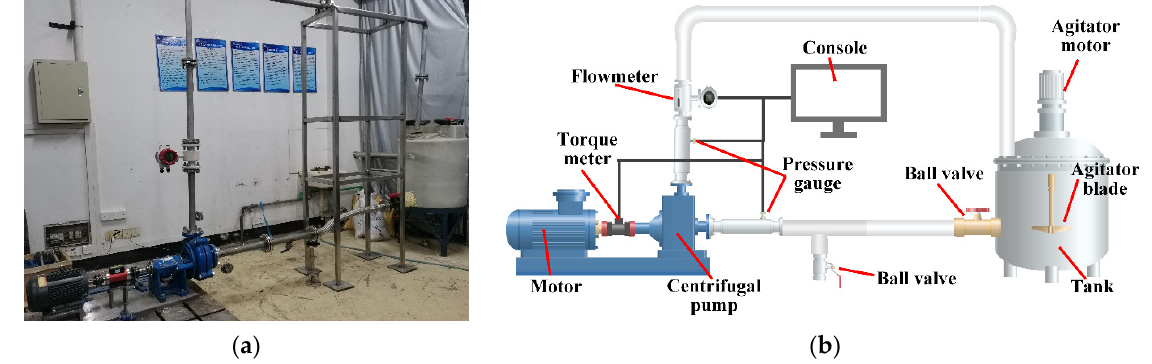
Figure 5. Experimental equipment: ( a ) physical picture; ( b ) schematic diagram.